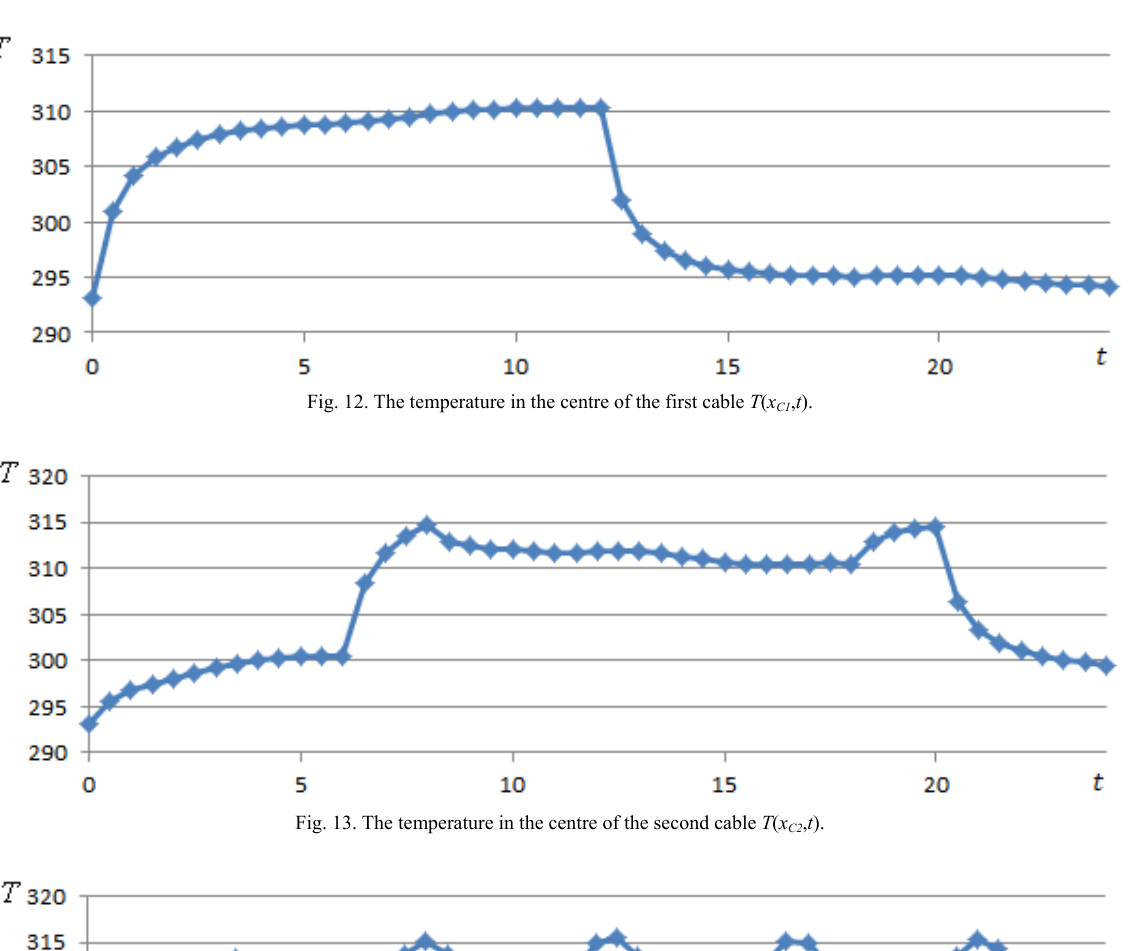
Fig. 11. Functions for parabolic problem solution: (a) function f 1 ( t ), (b) function f 2 ( t ), (c) function f 3 ( t ).